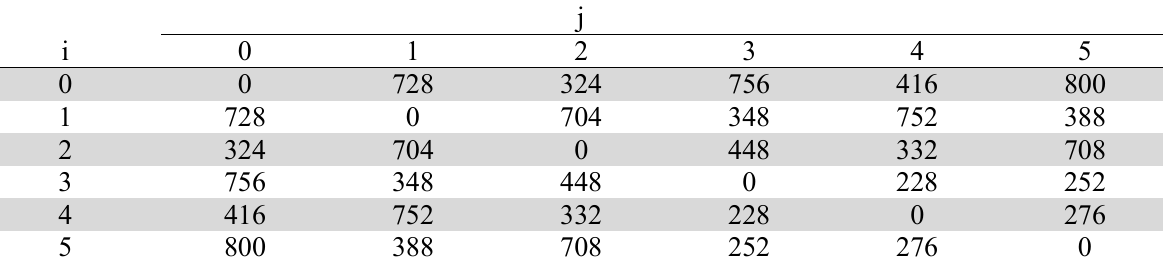
Transportation Cost